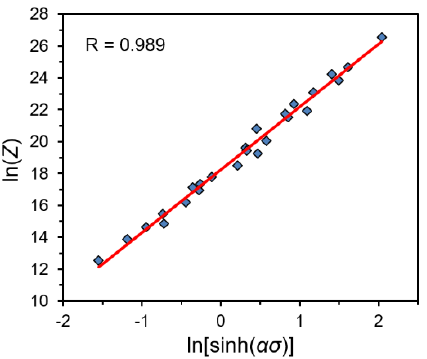
Figure 3. Relationships between ( a ) ln (cid:2013)(cid:4662) and ln σ , ( b ) ln (cid:2013)(cid:4662) and σ , ( c ) ln (cid:2013)(cid:4662) and ln[sinh( ασ )], ( d ) ln[sinh( ασ )] and (1/ T ) for a true strain of 1.